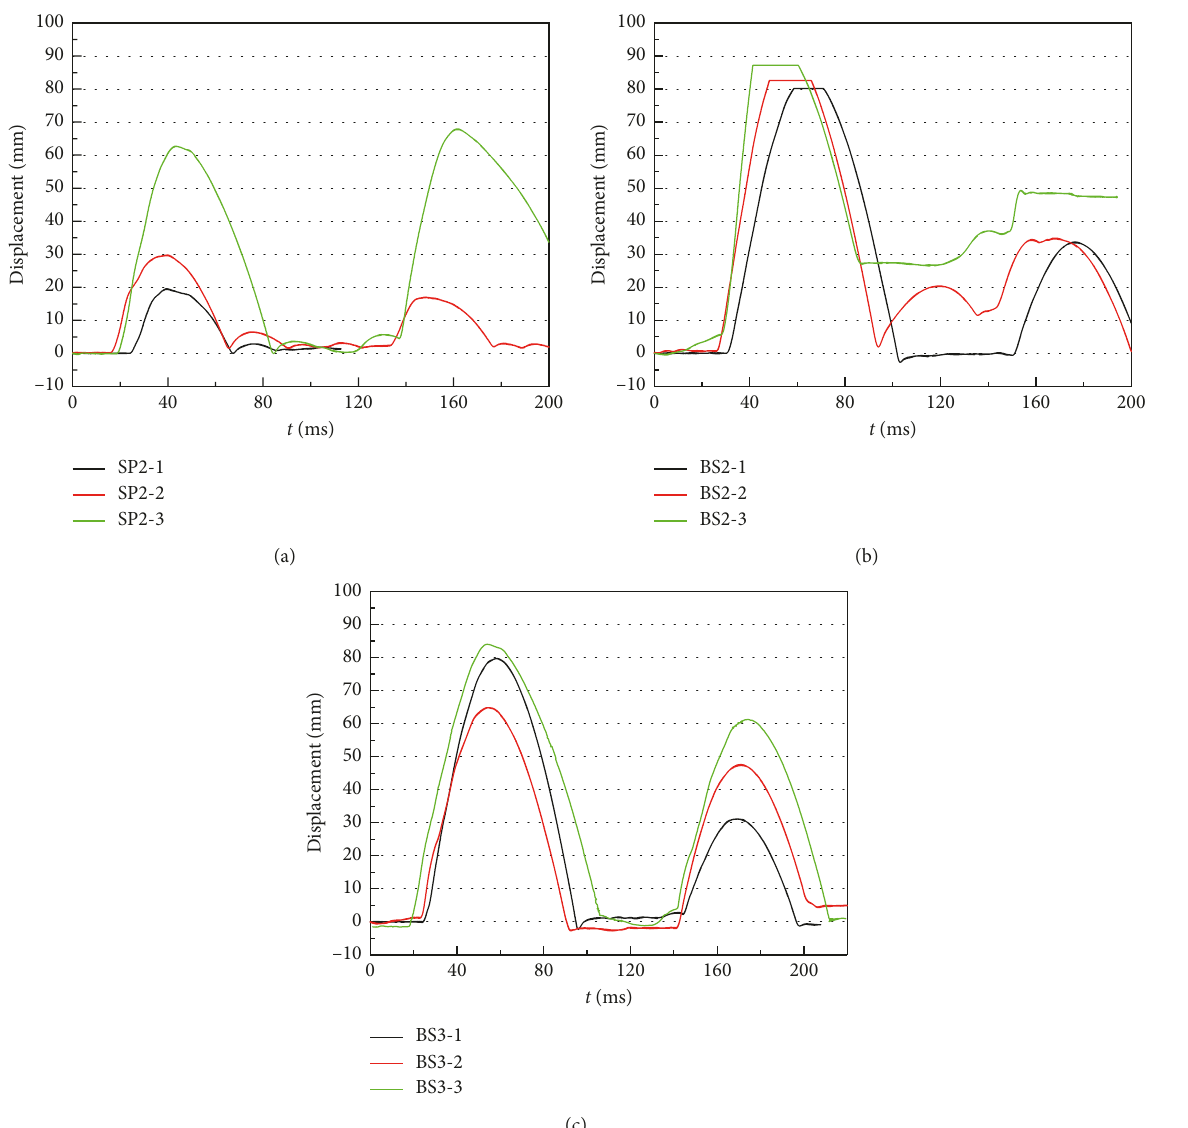
Figure 11: Time-displacement curves for slabs. (a) Time-displacement curve for SPs. (b) Time-displacement curve for BS2s. (c) Time- displacement curve for